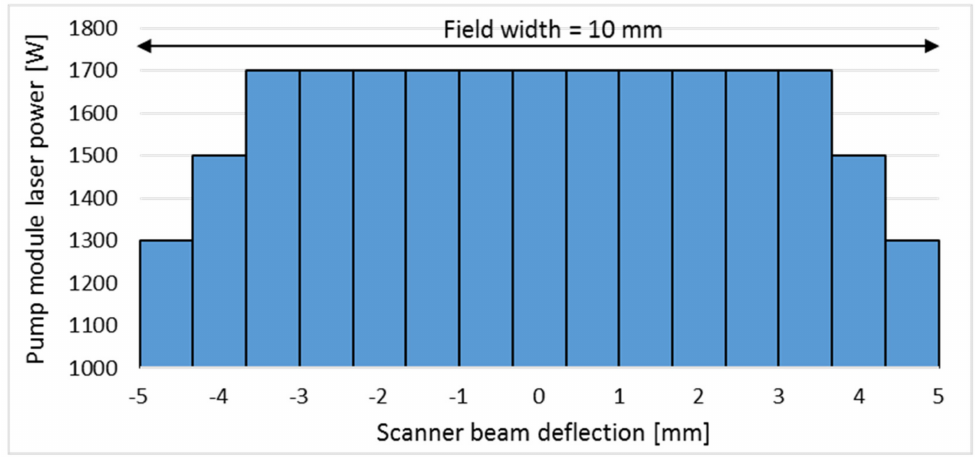
Figure 9. Adjustment of the pump module laser power over the scanner beam deflection (scanner pendulum movement).